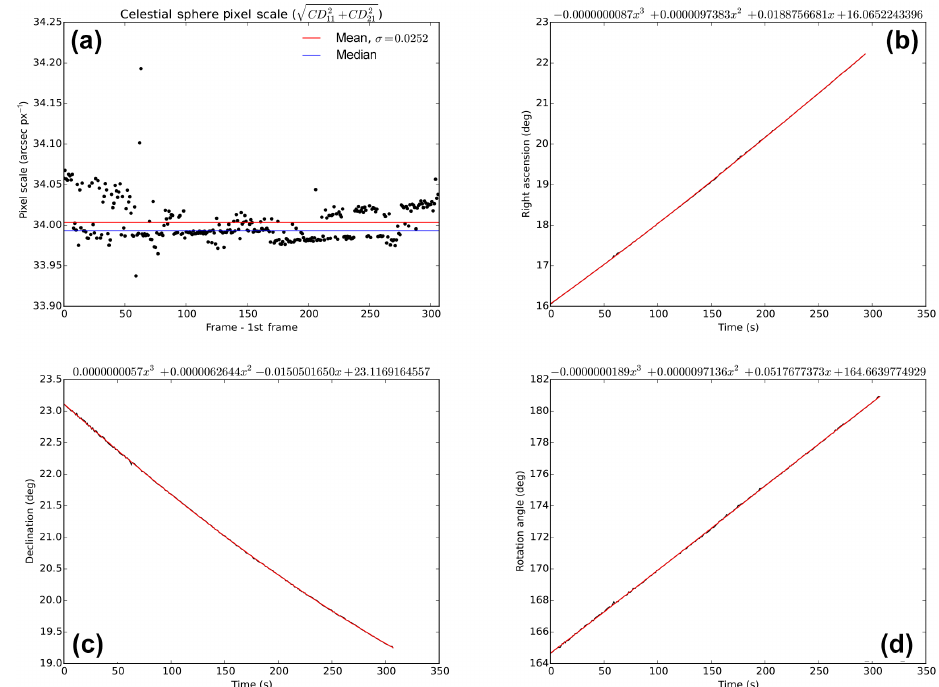
Figure 6. Astrometry parameters used for assessing the quality of a result. (a) The celestial sphere pixel scale for each image in a sequence (black) and its mean (red) and median (blue). Right ascension (b) , declination (c) , and rotation angle (d) of the image centroid (black) and polynomial fits to each of these